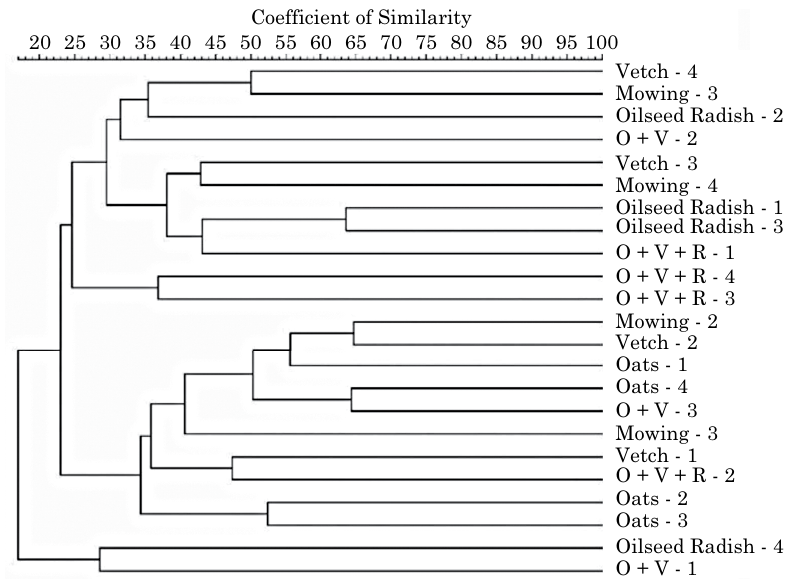
figure 1. dendrogram generated from pcr-dgge of 24 soil samples, collected at 110 days after planting the cover crops. Hierarchical clustering obtained from the Jaccard coefficient and the UPGMA clustering method. the nomenclature for samples refers to the cover crop treatments, and the numbers correspond to the